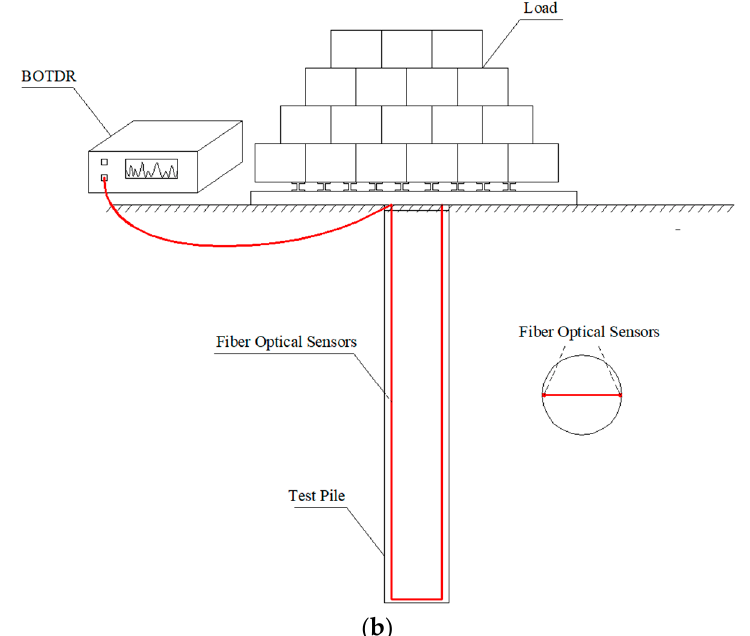
Figure 1. Optical fiber and schematic diagram of field test. ( a ) GFRP optical fiber; ( b ) Schematic diagram of field test.